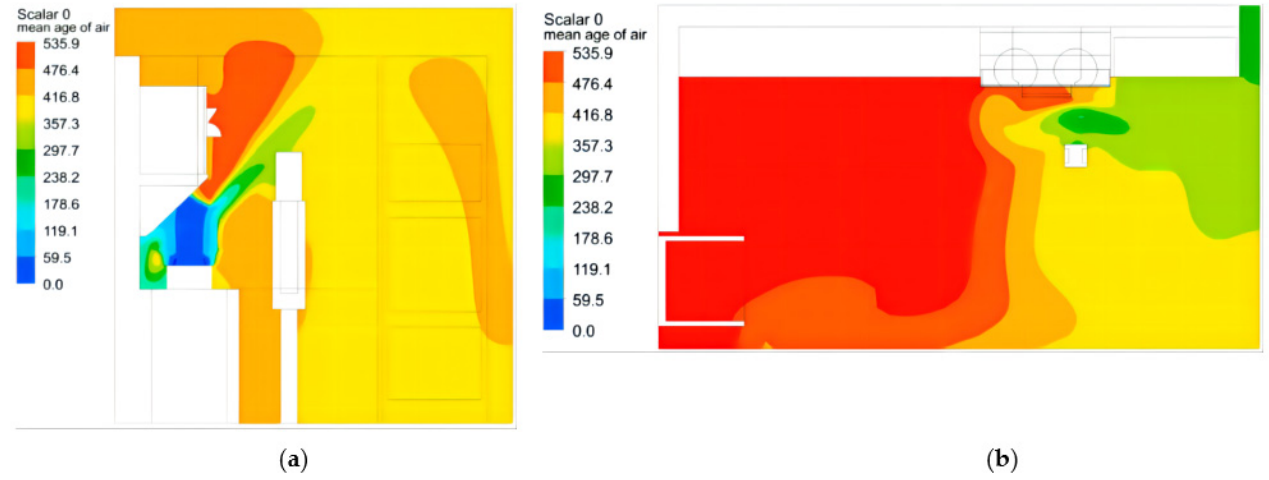
Figure 12. Fresh air off (990 s): ( a ) Air age distribution in the working area at z = − 2.62 m; ( b ) Air age distribution in the human breathing zone at y = 1.547 m.